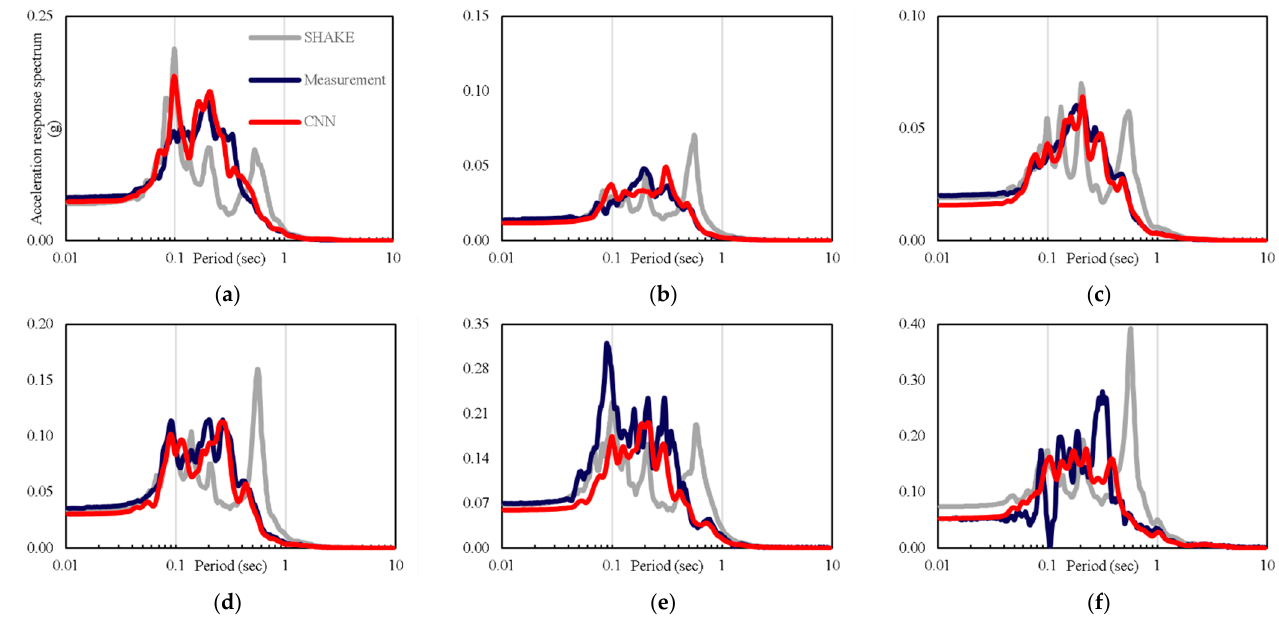
Figure 16. The six samples of acceleration response spectra measurements and predictions at site IWTH12. ( a )